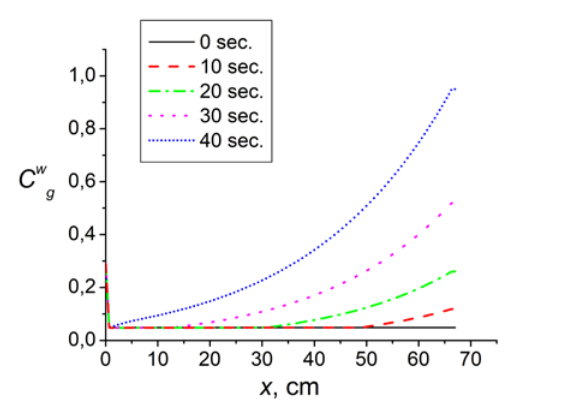
Fig. 5. Concentration of water steam in the gas phase in the heat pipe at different time moments.